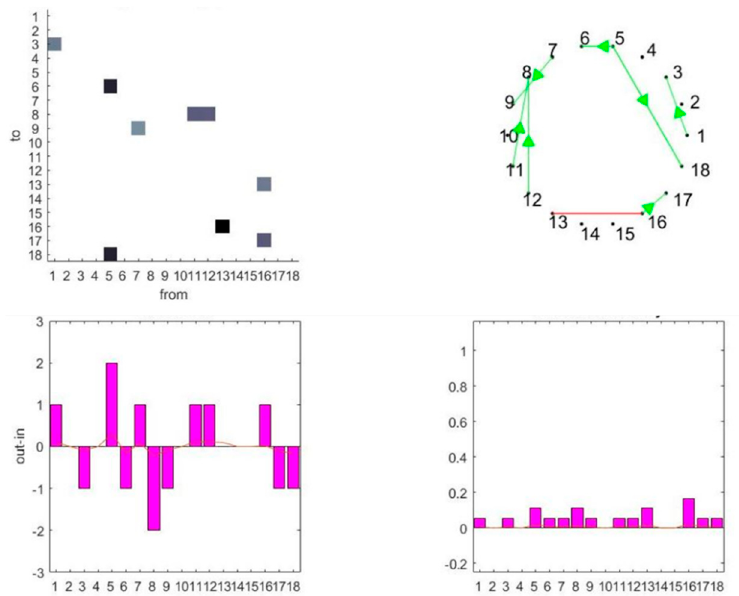
Figure 4. Study A: Demonstration of the GCCA. Matrix and network representations of the corresponding G-causalities are shown in the top panels. Causal flow and unit causal density are shown in the bottom panels.